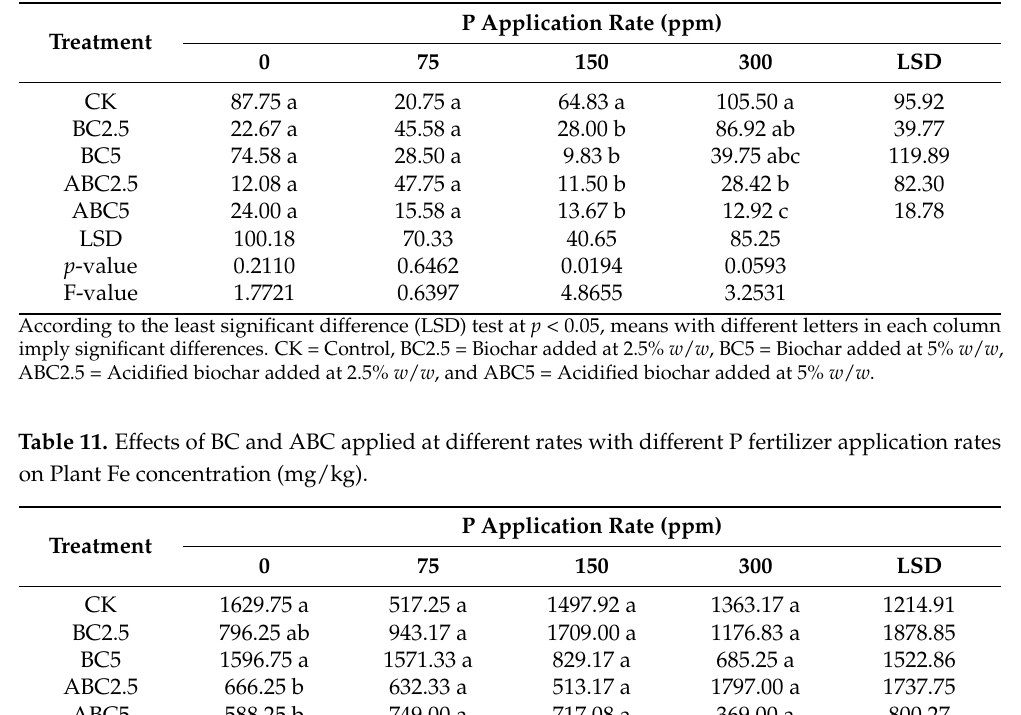
Table 10. Effects of BC and ABC applied at different rates with different P fertilizer application rates on Plant Cu concentration (mg/kg).